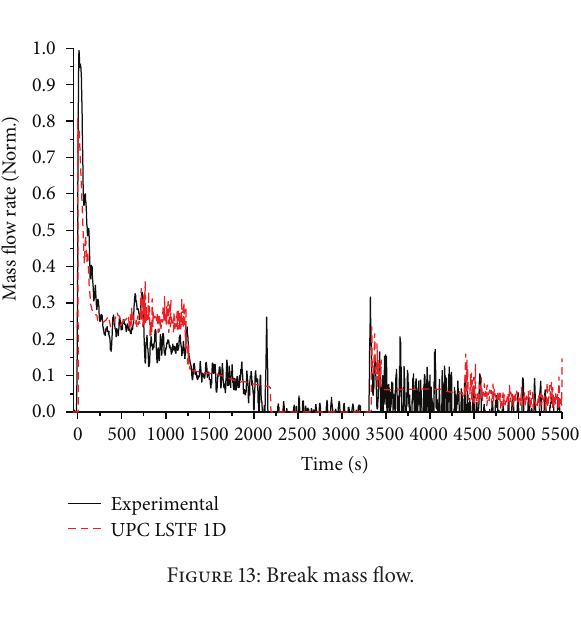
Figure 13: Break mass flow.